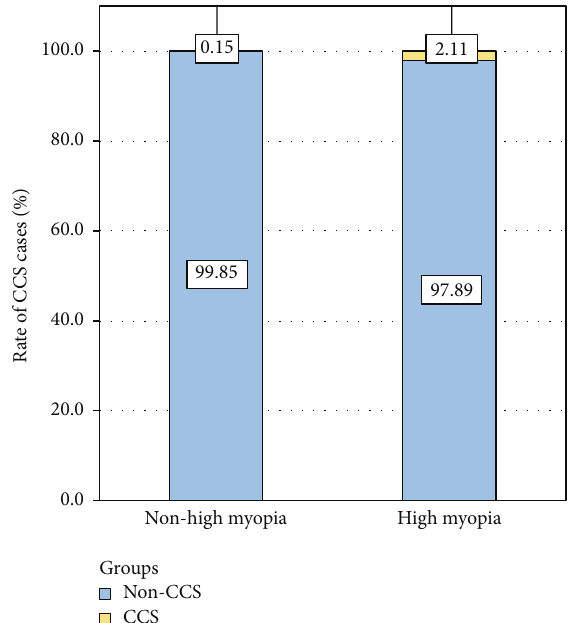
Figure 1: Incidence of capsular contraction syndrome in cataract patients with or without high myopia. CCS = capsular contraction